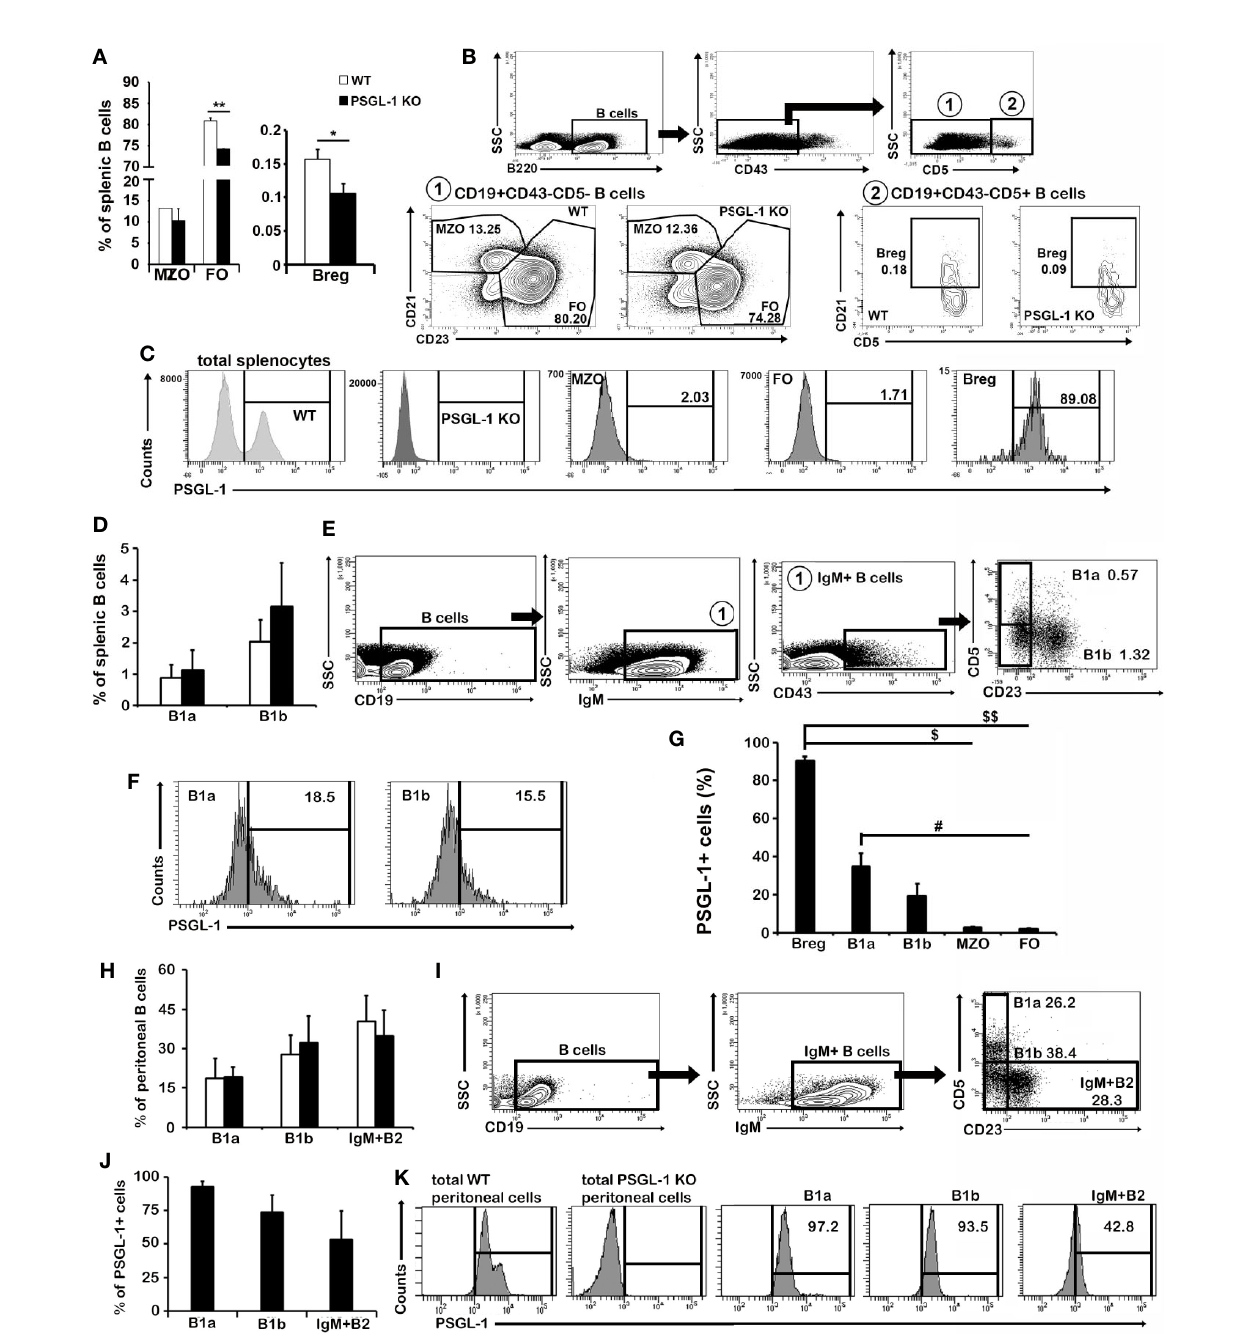
FIGURE 5 | PSGL-1 is differentially expressed in splenic and peritoneal B1 and B2 cells. (A) Relative frequencies of the B2 different subsets of marginal zone (MZO), follicular (FO), and regulatory B cells (Breg) in the spleen of WT and PSGL-1 − / − mice. (B) Gating strategy and representative density plots showing Breg, FO, and MZO B cells of WT and PSGL-1 − / − mice. (C) Representative histograms showing the expression of PSGL-1 in total spleen cells and in the different subsets of B2 cell subpopulations studied in WT and PSGL-1 − / − mice. (D) Relative frequencies of B1a and B1b cell subsets in the spleen of WT and PSGL-1 − / − mice. (E) Gating strategy and representative density and dot plots showing splenic B1a and B1b cell subsets. (F) Representative histograms showing the expression of PSGL-1 in WT B1a and B1b cells. (G) Percentage of PSGL-1 expressing cells of different subsets of B1 and B2 cell subpopulations. (H) Relative frequency of B1 and IgM + B2 cells in the peritoneal cavity of WT and PSGL-1 − / − mice. (I) Gating strategy and representative density and dot plots showing peritoneal B1a and B1b cell subsets. (J, K) Percentage of PSGL-1 + cells (J) and PSGL-1 expression representative histograms (K) of peritoneal B1a, B1b, and IgM + B2 cells. Bars represent the mean+standard deviation. (A) Breg *p < 0.05, FO **p < 0.01; (G) Breg: $ p < 0.05, $$ p < 0.01, B1a: # p < 0.05; by Kruskal-Wallis test. In all cases, n = 4 – 6 mice per